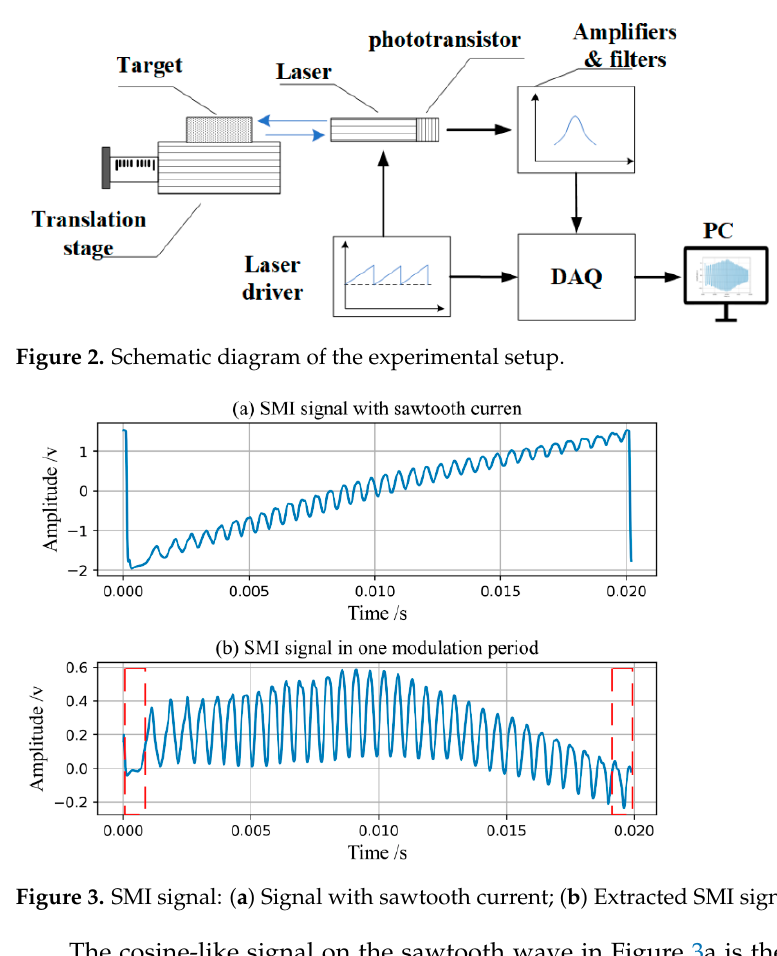
Figure 3. SMI signal: ( a ) Signal with sawtooth current; ( b ) Extracted SMI